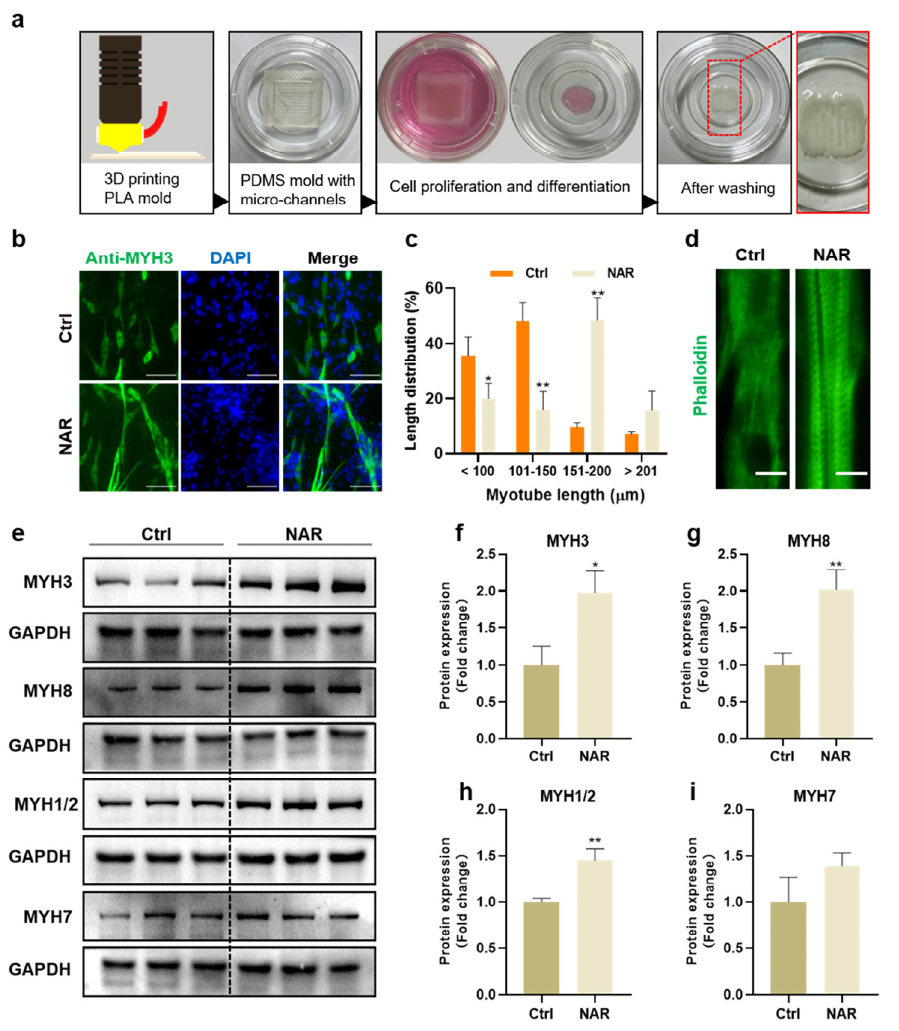
Figure 6. NAR promoted the generation of mature myotubes in a three-dimensional differentiation condition. ( a ) A schematic diagram of mold fabrication and cell culture for cultured pork manufacture. ( b ) Representative immunofluorescent images of differentiating myotubes after seven days of culture in differentiation medium with or without NAR (20 µM). Green, anti-MYH3; blue, DAPI. Scale bar, 100 µm. ( c ) Myotube length distribution as a percentage according to immunofluorescent images ( n = 3 biological replicates). ( d ) Representative immunofluorescent images of sarcomere microstructures. Green, phalloidin; blue, DAPI. Scale bar, 30 µm. ( e ) Representative blots of MYH3, MYH8, MYH7, MYH1/2, and GAPDH proteins from cultured pork samples, which were differentiated with or without NAR (20 µM) for seven days. ( f – i ) Quantification of MYH3, MYH8, MYH7, and MYH1/2 expression normalized to GAPDH from Western blot gels and presented as fold change relative to the ctrl sample. Error bars represent mean ± SD ( n = 3 biological replicates). The asterisk indicates a significant difference from the Ctrl group. * p < 0.05, ** p < 0.01.